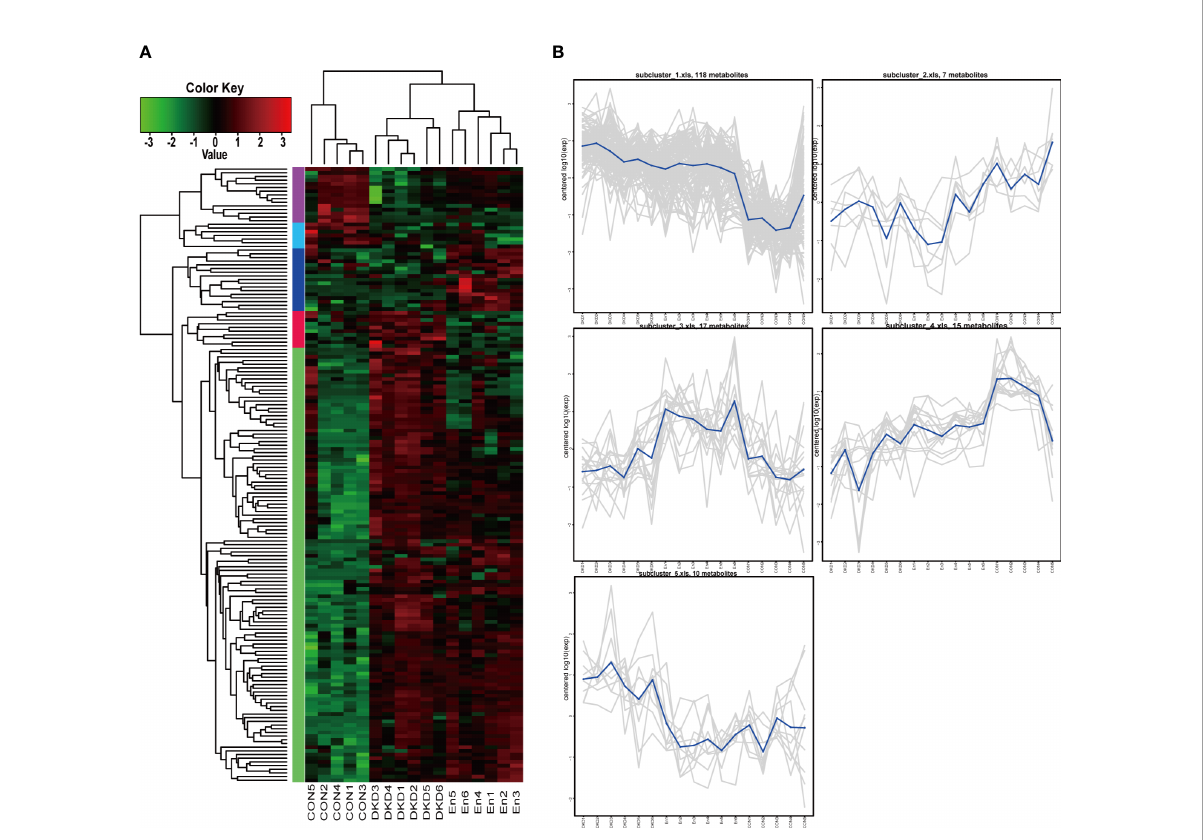
FIGURE 6 Cluster analysis of differential metabolites. (A) Heat map of differential metabolite cluster. (B) Line plots of expression trend of 5